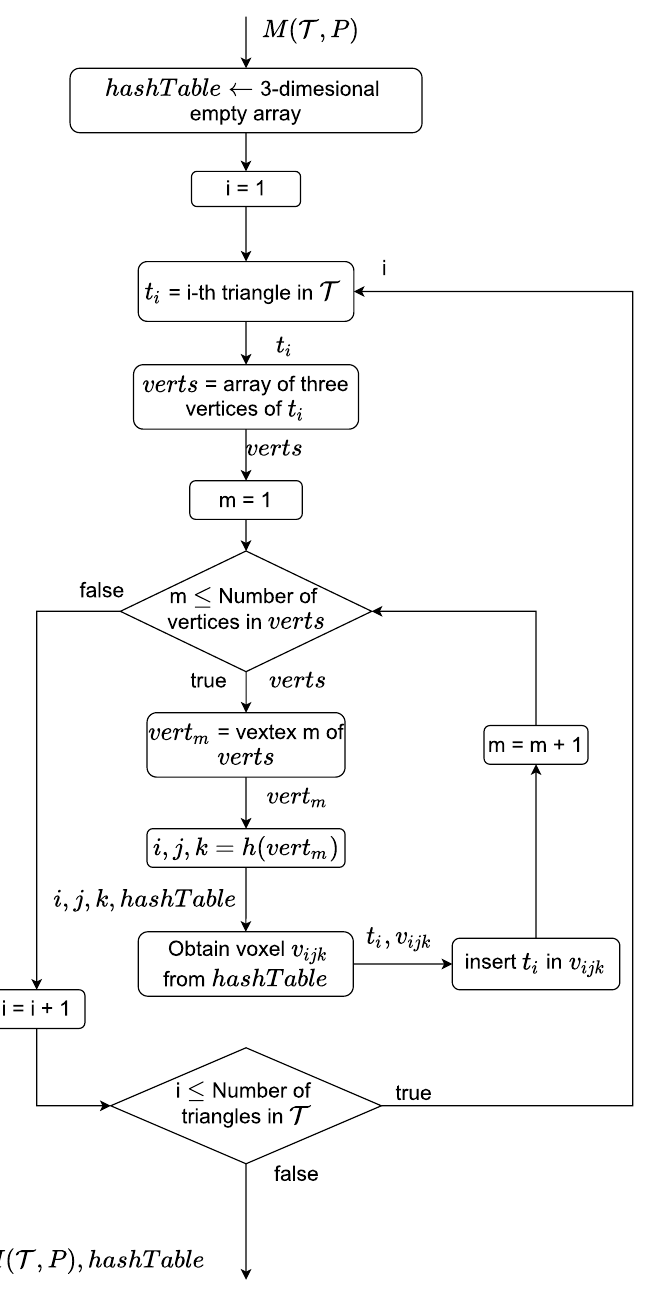
Figure 4. Spatial hashing preprocessing. The hashing is executed before the fitting process starts. Table 3. FACE table constructed from